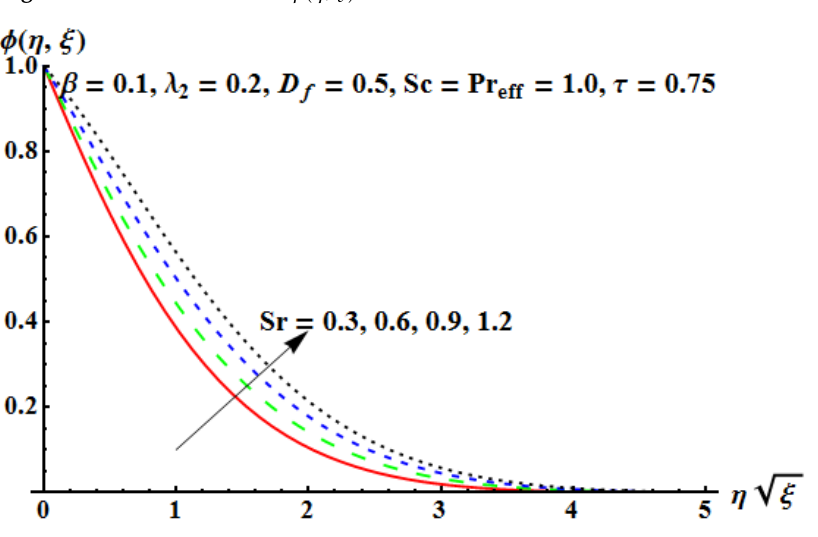
Figure 13. Influence of Sr on φ ( η , ξ )